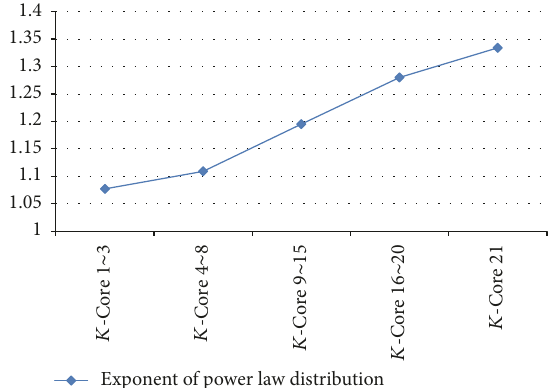
Figure 4: Exponent of power-law distribution for different user